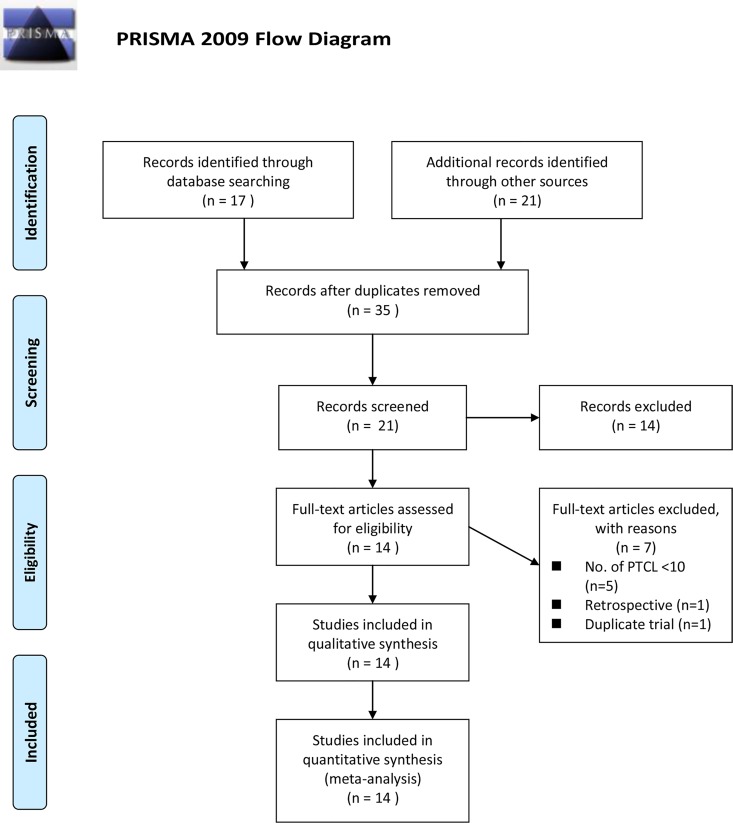
PRISMA 2009 Flow Diagram.